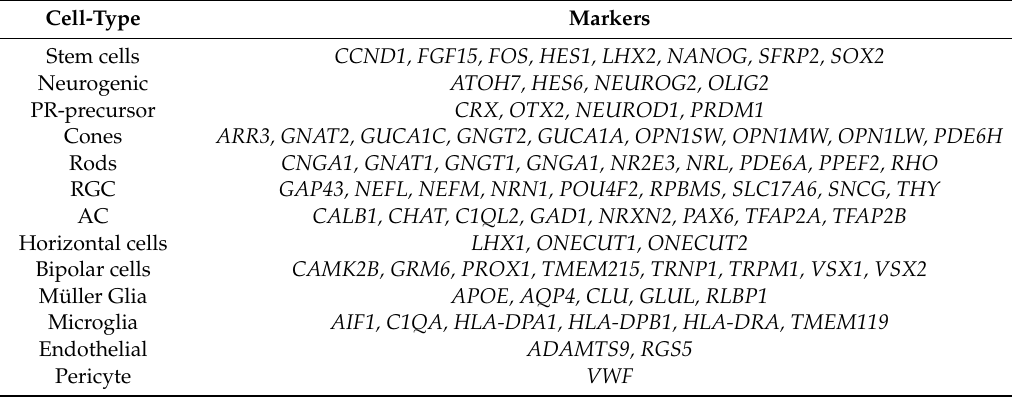
Table A1. Gene markers used for overlapping annotation in organoids. This table shows the markers gathered from the literature to annotate the scRNA-seq clusters according to the higher retinal cell-type